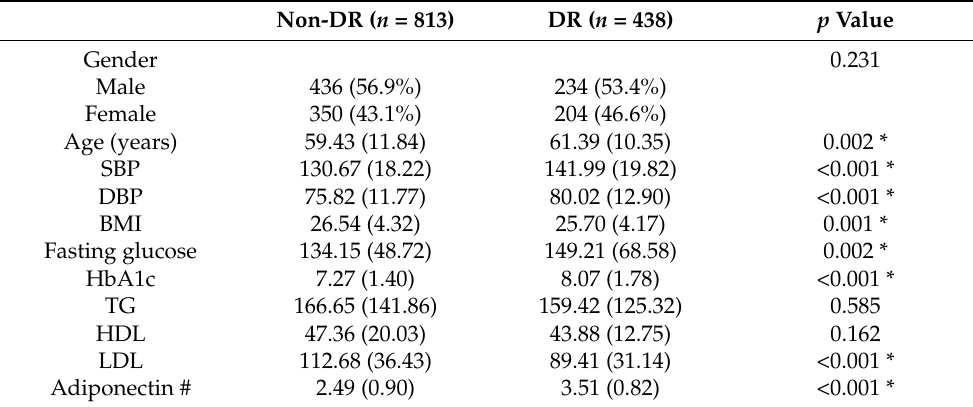
Table 1. Demographics of the study